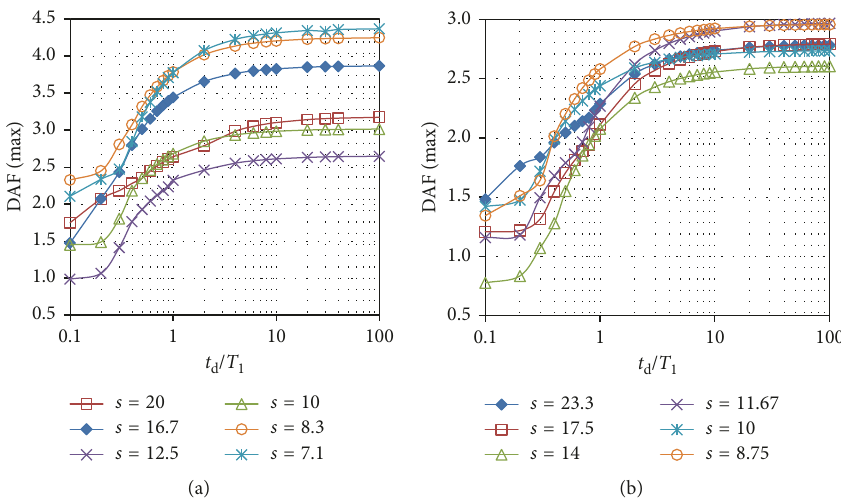
Figure 5: DAF (max) of shear force of bridge columns under impact load with right triangle shape for different boundary conditions. (a) F-F. (b) F-H.